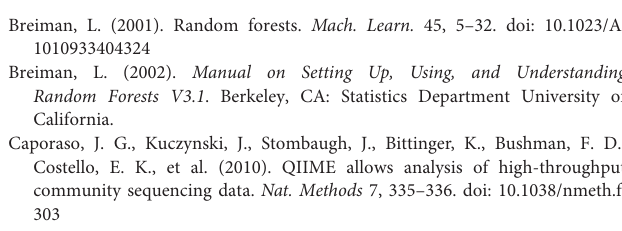
TABLE S3 | Differently distributed pathways between caries-free and caries-affected children. TABLE S4 | Prediction result of validation samples using caries-onset prediction model. DATA SHEET S1 | OTU annotation of all